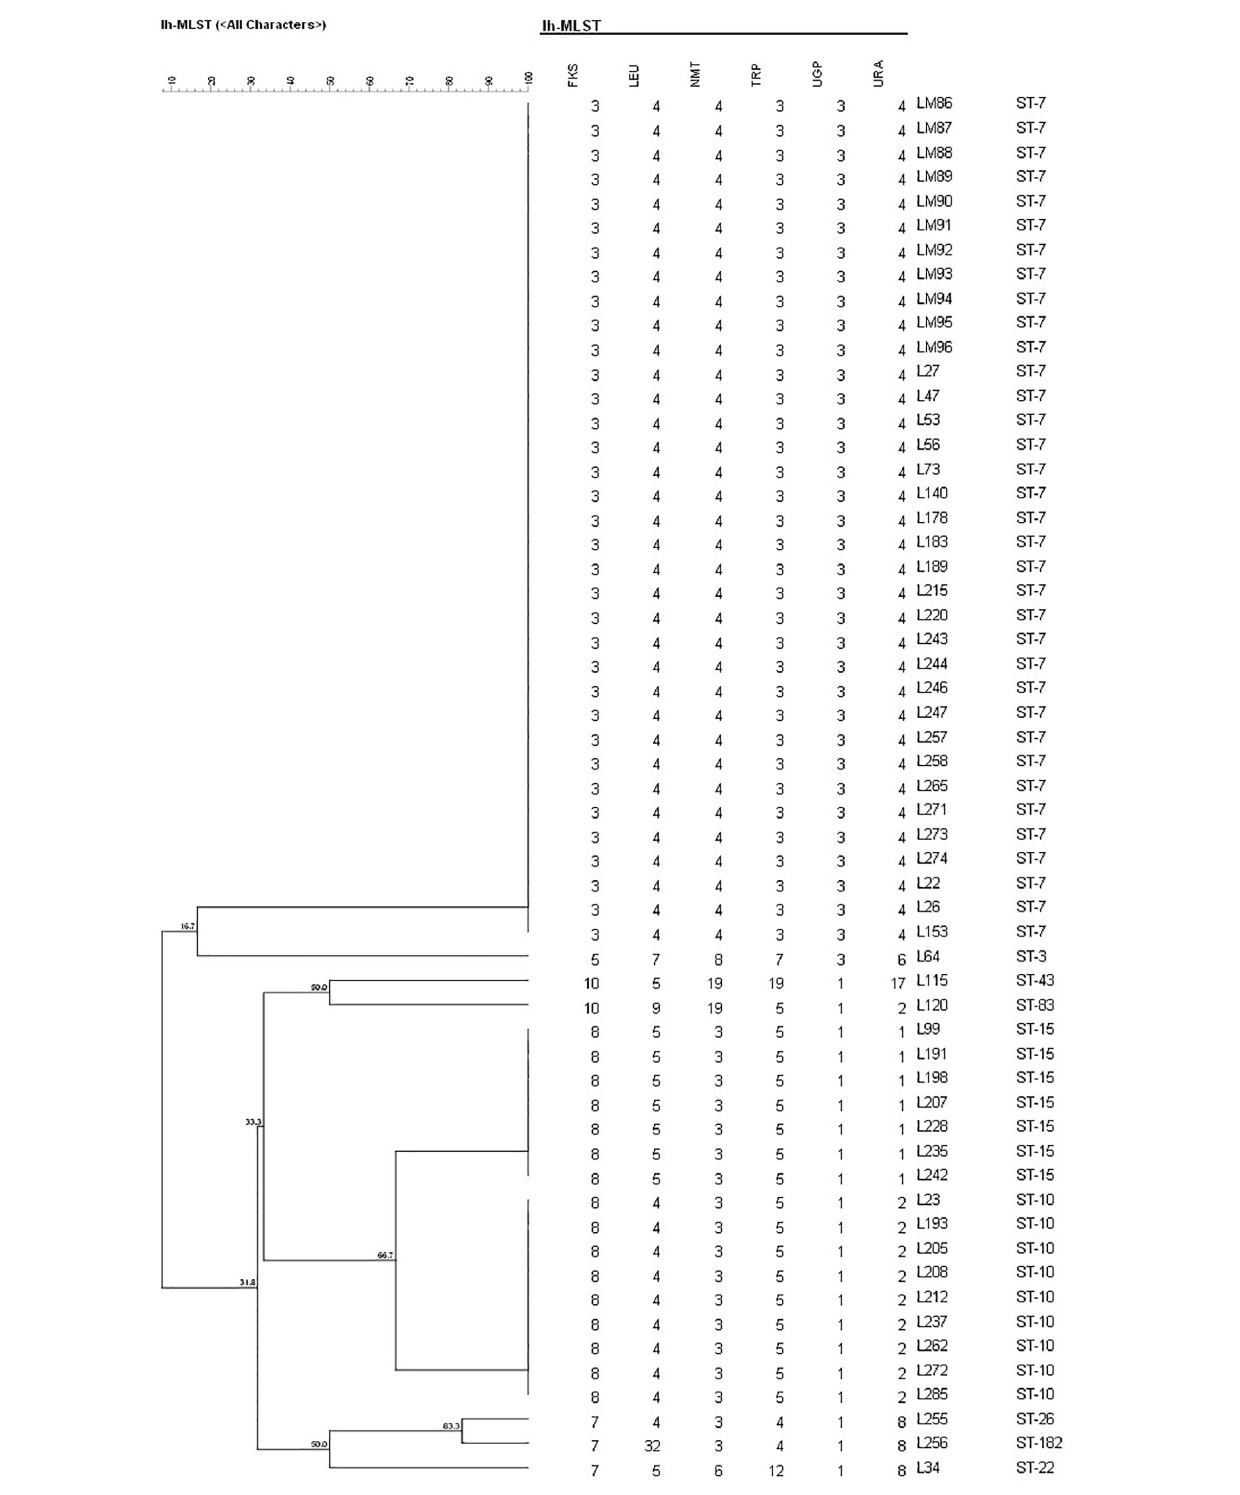
Frontiers in Microbiology |